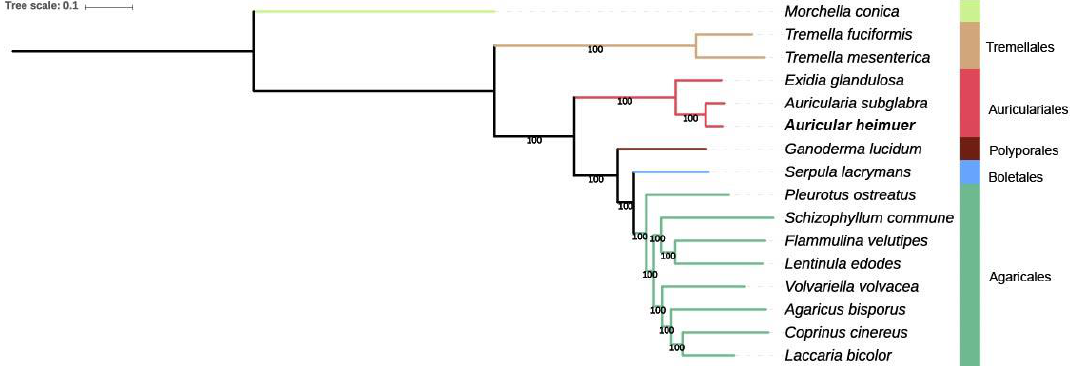
Figure 4. Phylogenomic tree of 15 mushroom species based on single-copy orthologous genes. The mushroom species separated into three main groups. Morchella conica was used as the outgroup. The di ff erent orders are indicted by di ff erent colored bars. Tree scale = 0.1. The numbers under bars indicate 100%